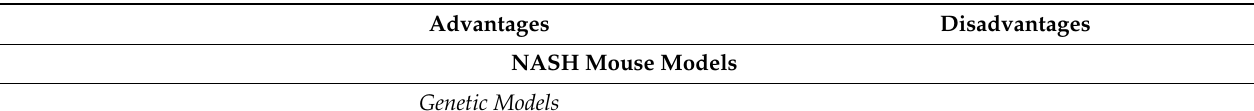
Table 1. Cont . Advantages